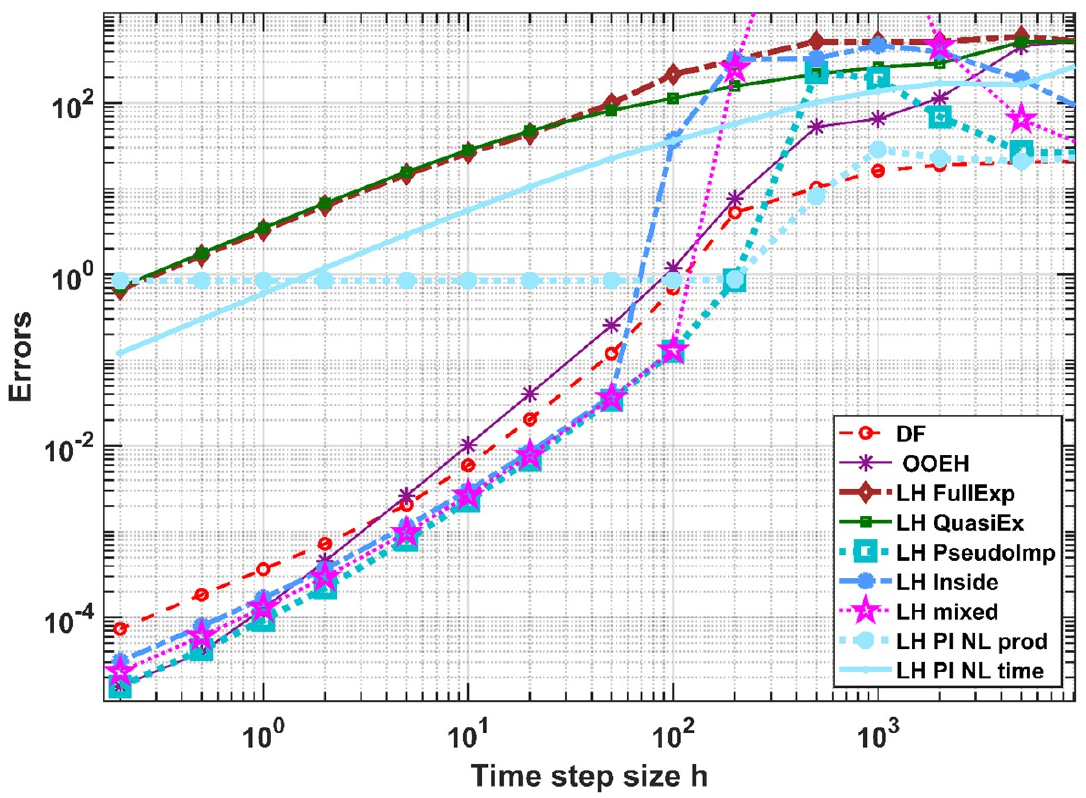
26 of 29 Figure 18. The distribution contour of the temperature in Kelvin for the non-equidistant mesh at